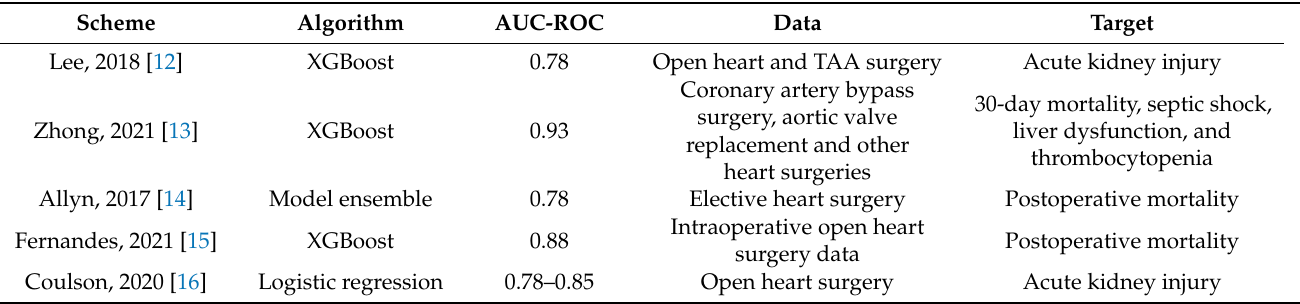
Table 1. Recent studies for cardiovascular predictive